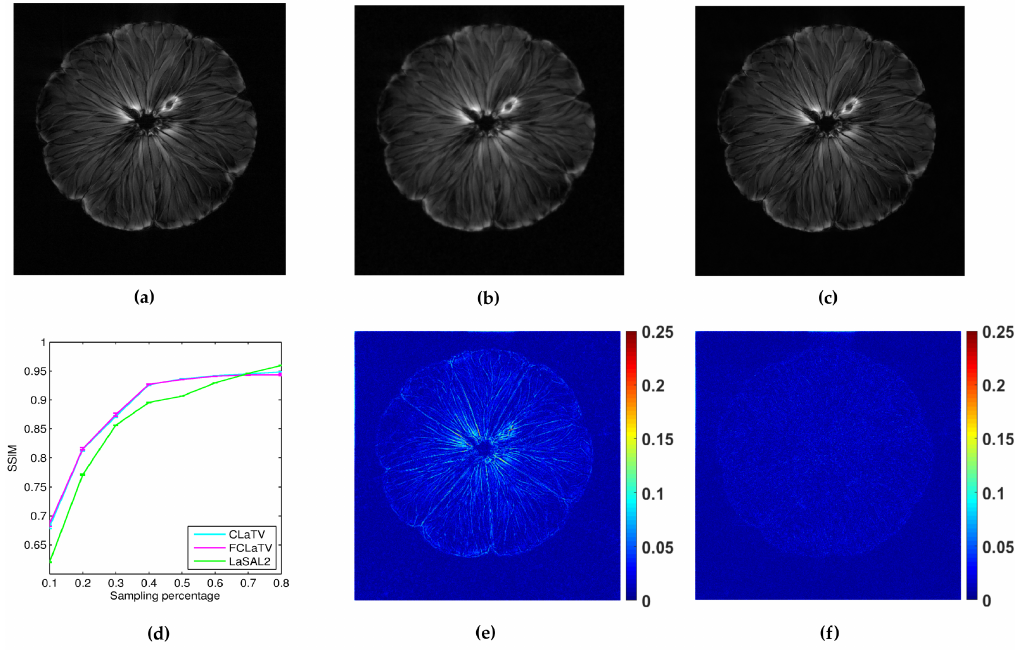
Figure 8. Reconstruction of pomelo fruit from radially sampled measurements: ( a ) reference image obtained by conjugate gradient method using all measurements, ( b , c ) pomelo reconstructions using LaSAL2 and FCLaTV methods respectively from 40% of measurements, ( d ) average SSIM for different sampling rate, ( e , f ) corresponding reconstructions errors using LaSAL2 and FCLaTV methods